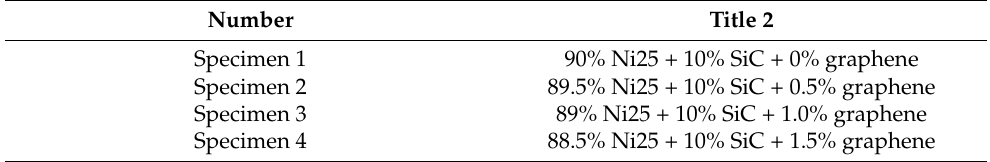
Table 1. Powder composition for laser cladding.